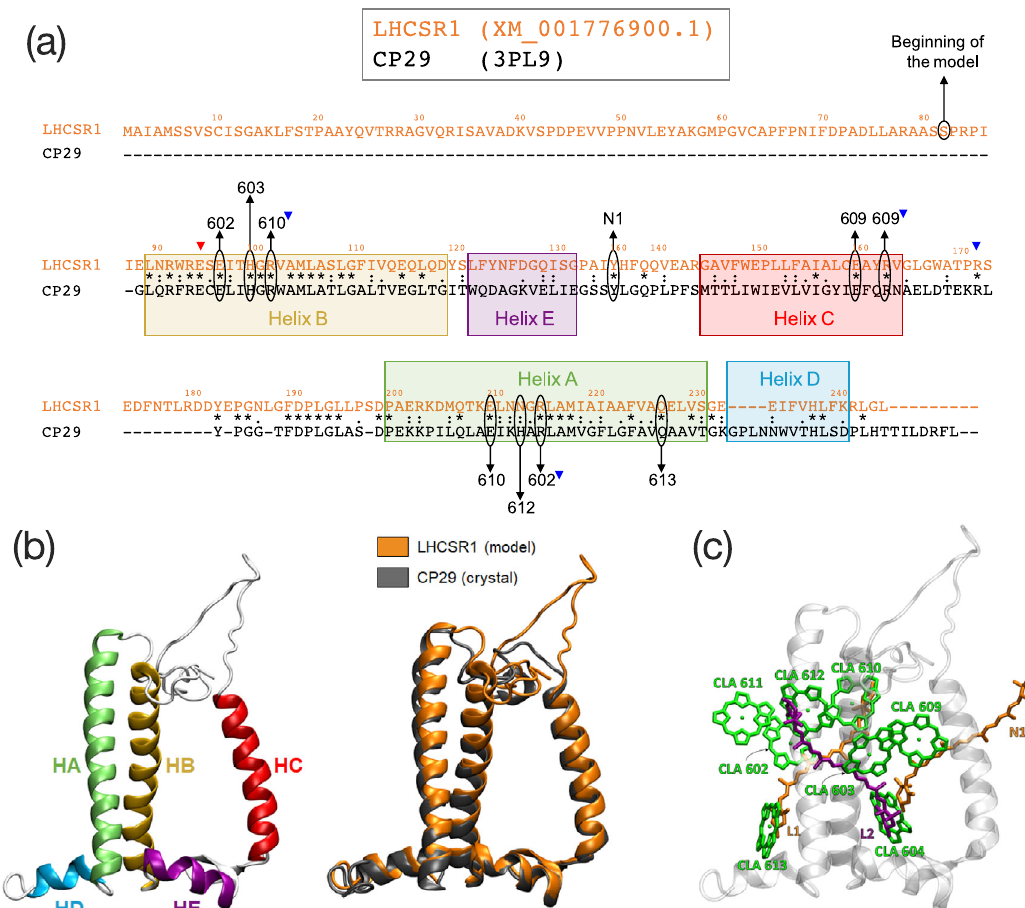
Fig. 1 Structural details of LHCSR1 after homology-modeling. a Sequence alignment between CP29 ( Spinacia oleracea ) and LHCSR1 ( Physcomitrella patens ). The color squares project the CP29 α -helices in the LHCSR1 sequence after the homology modeling. “ * ” indicates conserved residues, “ : ” indicates strong similarity, while “ . ” indicates weak similarity. Conserved binding sites of the Chls are indicated with the Chl number, with a downwards-pointing blue triangle indicating the salt-bridge Arg residue participating in the binding site. The N1 binding site of CP29 is also indicated with “ N1 ” . Additional conserved residues participating in salt bridges on the stromal side are indicated with downwards-pointing triangles (red/blue for acidic/basic residues). b Helices nomenclature and comparison of the model of LHCSR1 as predicted by homology modeling (orange) with the parent structure CP29 (PDB: 3PL9) 16 . c Representation of the pigment arrangement in the modeled LHCSR1 system: chlorophylls (all of type “ a ” - CLA) are represented in green, luteins in orange, and violaxanthin in